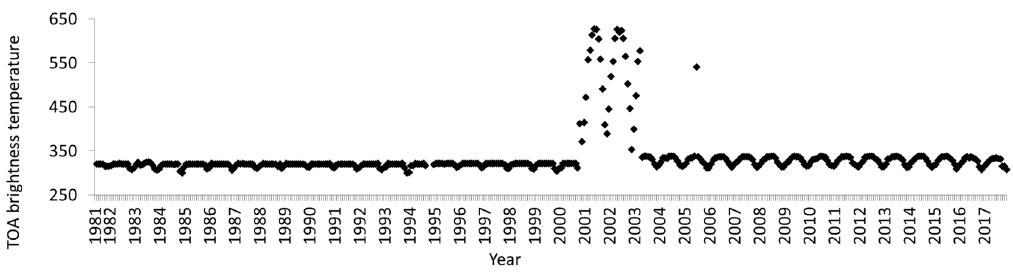
Figure 4. Time series of brightness temperature for channel 3 (3.55–3.93 µm) for a pixel located in the Sahara Desert. The impact of changes related to the daytime configuration of AVHRR3 (1.58–1.64) can be clearly seen between 2000–2003. In 2003, the previous configuration was restored.